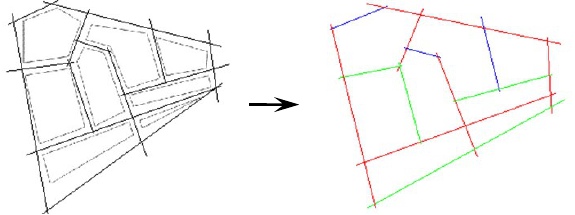
Figure 1. Spatial segmentation of axes